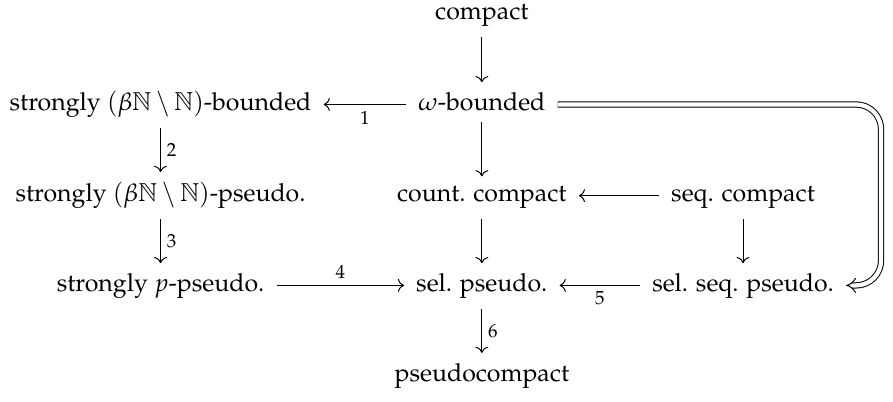
Figure 1. Implications between notions introduced in Section